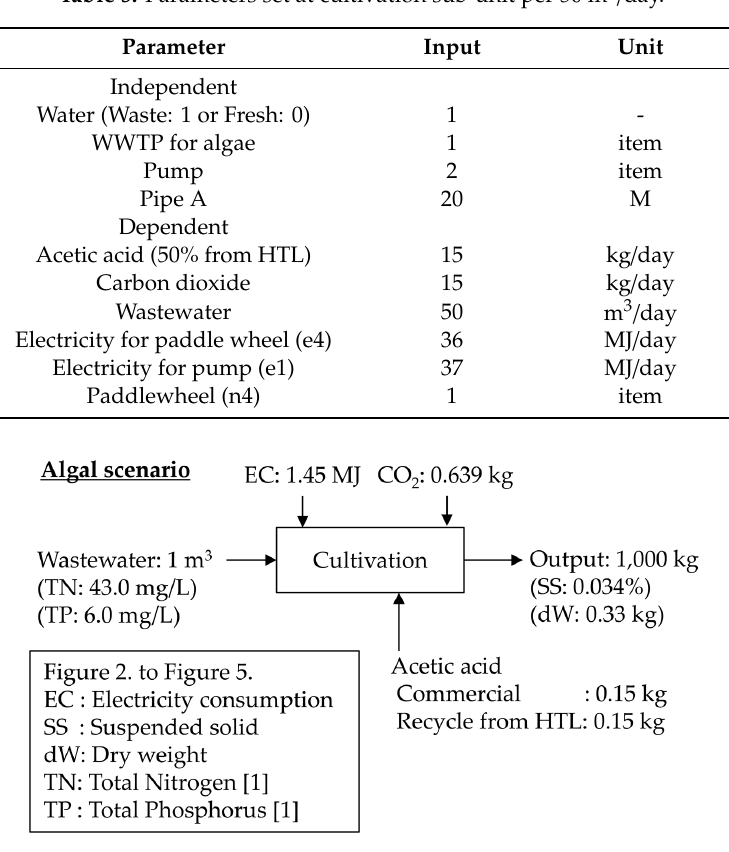
Figure 3. Mass balance of microalgae oil production in cultivation sub-unit per 1 m 3 .